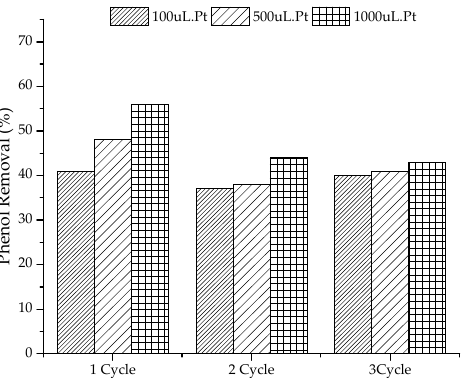
Figure 12. Result of photocatalyst reuse (every test lasted for 5 h under UV irradiation, 0.0125 g of catalyst, and an amount of platinum (100, 500, or 1000 μ L)).